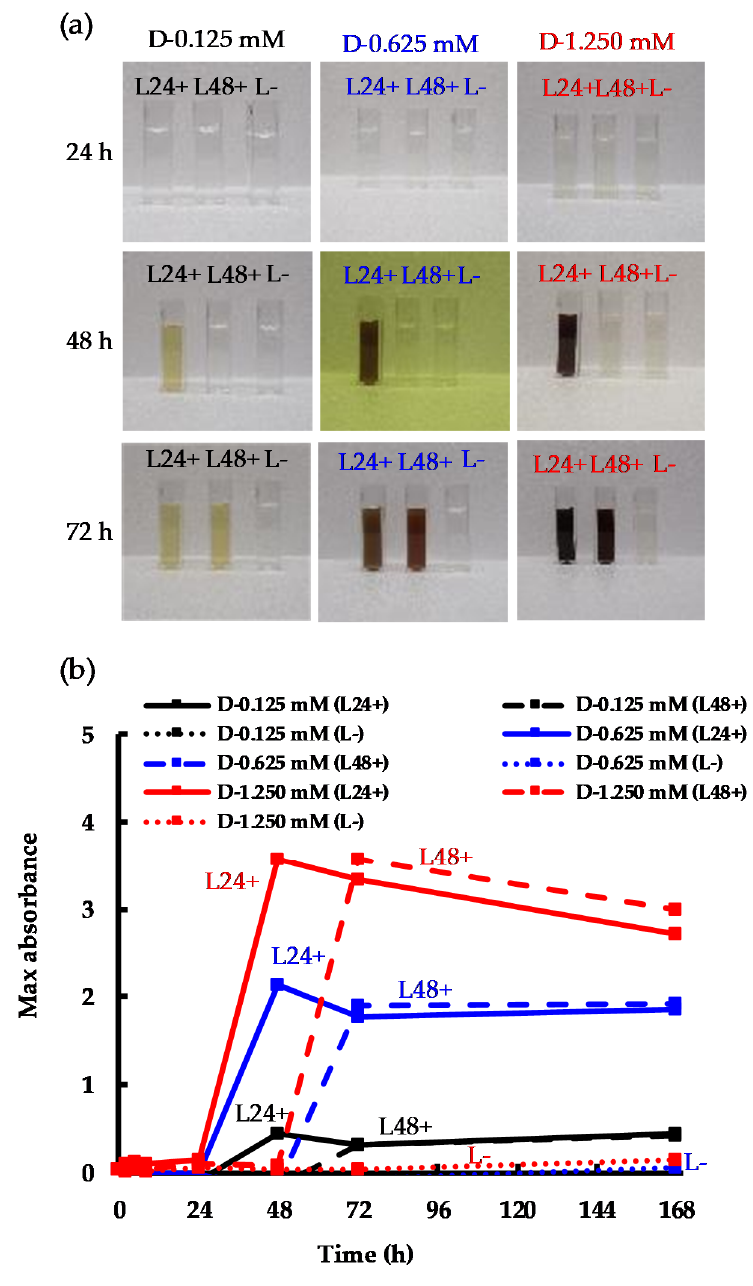
Figure 3. Experiments initially kept in the dark and then exposed to light after 24 h and 48 h: ( a ) change in color; ( b ) change of AgNP SPR intensity vs. time over 168 h.